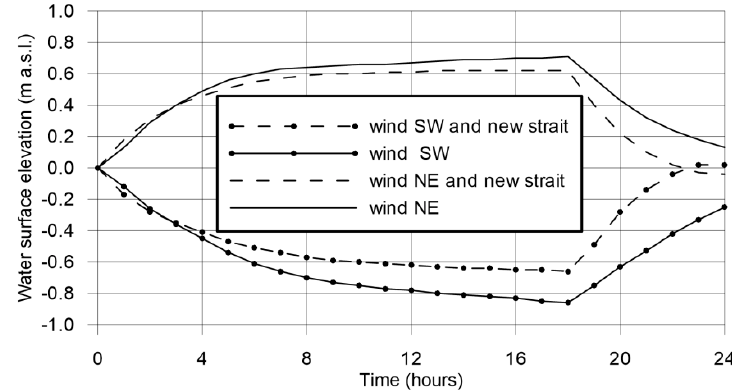
Figure 14. Water flow velocity (m s − 1 ) after 12 h of a SW wind at a speed of 12 m s − 1 and with the new artificial strait at point E (dimensions in meters).